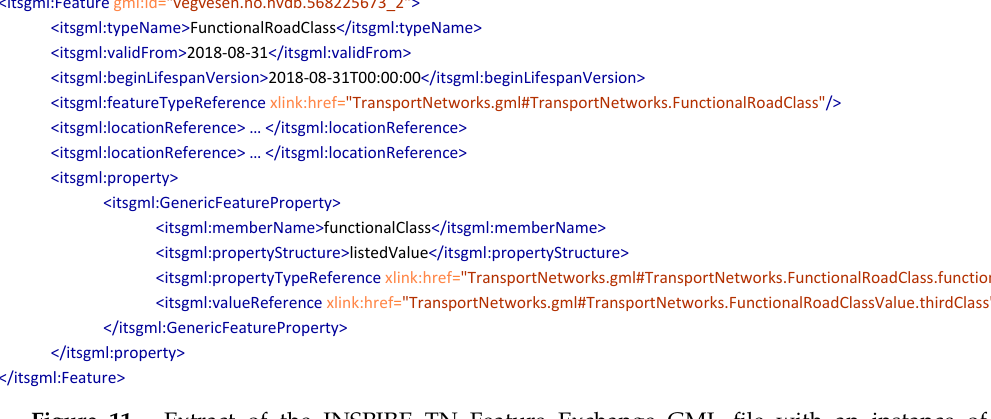
Figure Figure 11. Extract of the INSPIRE TN Feature Exchange GML file with an instance of the FunctionalRoadClass feature type.